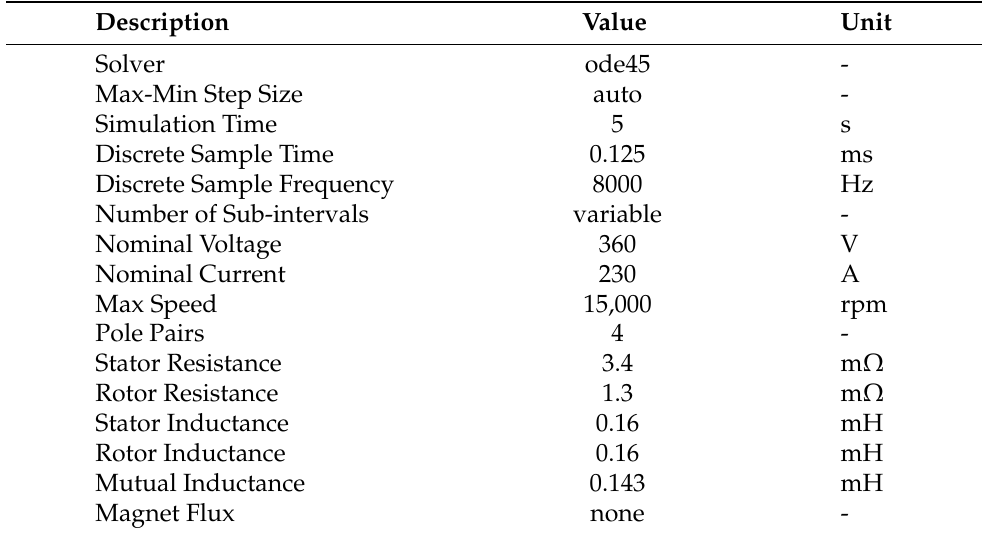
Table 1. Simulink general simulation and machine parameters for every implementation used.